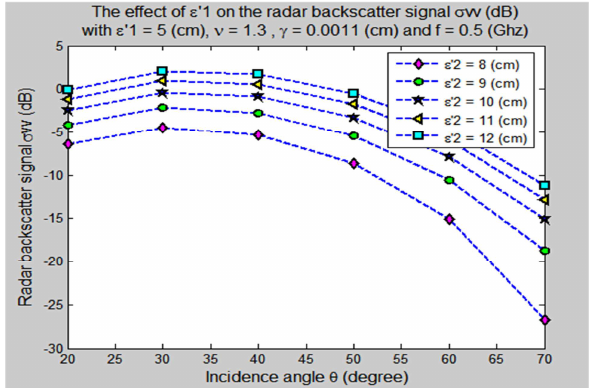
Figure 12.Backscattering coefficient dependence on ε ’ 2 at